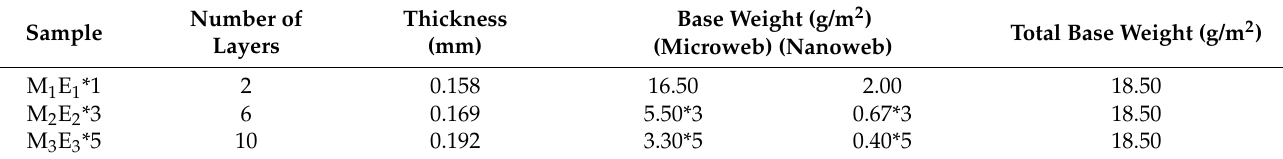
Table 1. Parameters of laminated